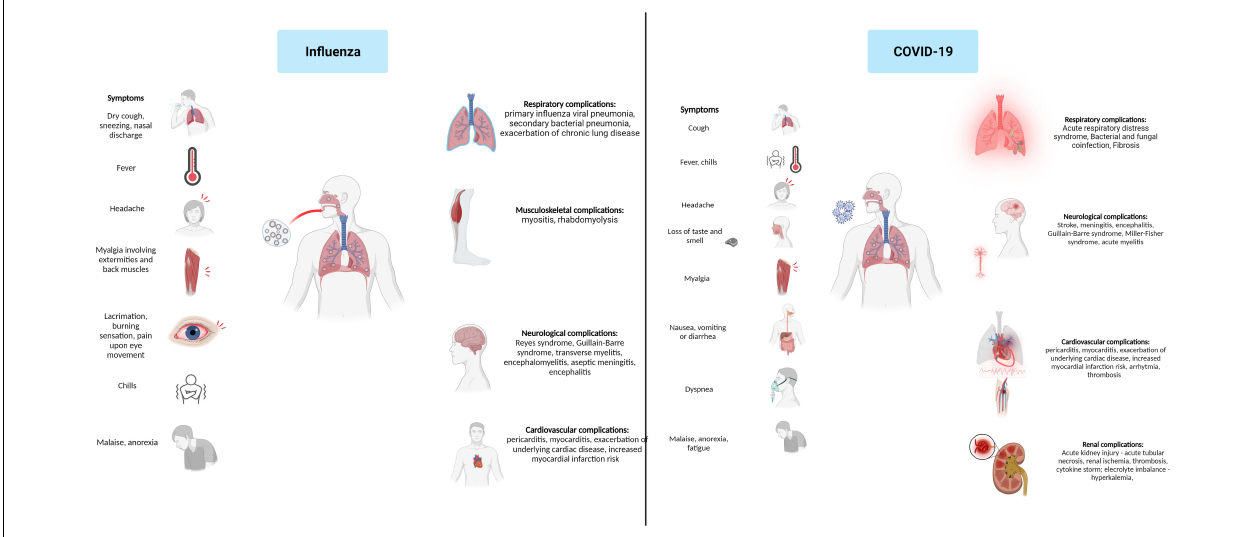
FIGURE 3 | Influenza and COVID-19 clinical presentation and associated